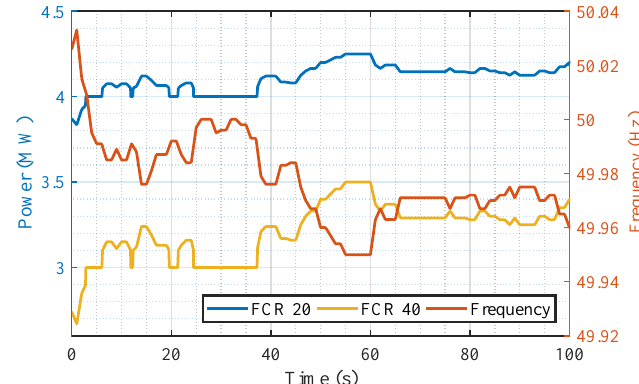
Figure 10. Power reference for the 20 and 40% FCR